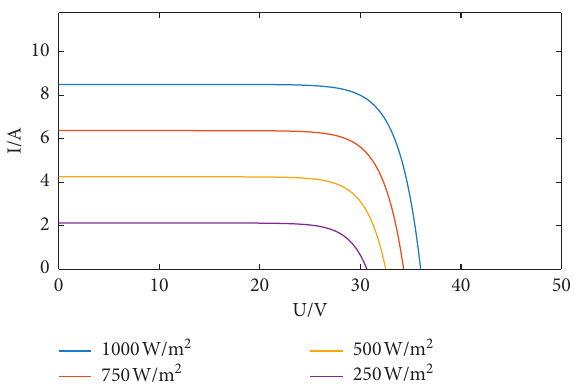
Figure 5: I-U output curve of the photovoltaic cell when the light intensity changes.